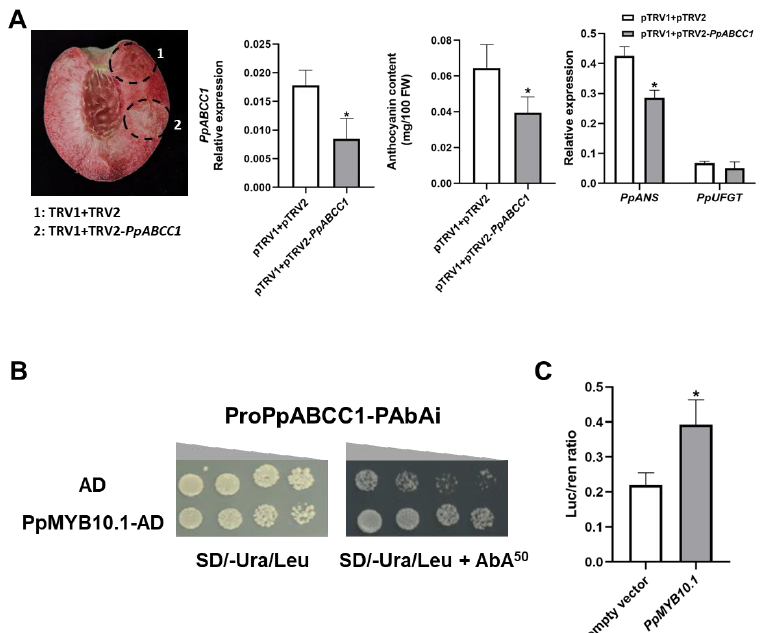
Figure 8. Functional analysis of the PpABCC1 gene: ( A ) Transient silencing of PpABCC1 in the fruit of blood peach ‘Dahongpao’ at S2 using virus-induced gene silencing (VIGS) system. Expression of PpABCC1 and anthocyanin biosynthetic genes and anthocyanin content were measured in the flesh tissues around the infiltration sites. ( B ) Assay of the interaction between PpMYB10.1 and the promoter of PpABCC1 using yeast one-hybrid (Y1H). ( C ) Assay of the activation activity of PpMYB10.1 on the promoter of PpABCC1 using dual luciferase reporter system. Data represented means (±SD) of three independent biological replicates. *, Significant difference at p < 0.05 level. 2.9. Transcriptional activation of PpABCC1 by PpMYB10.1